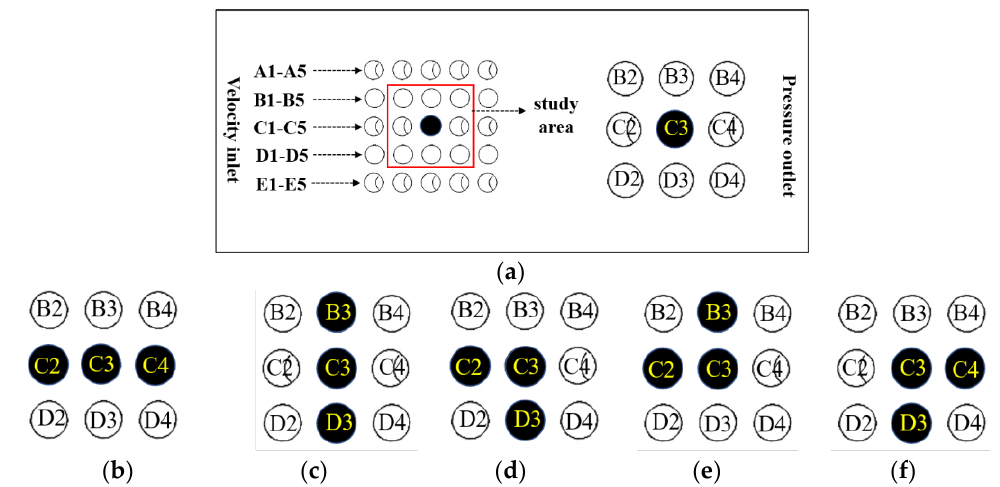
Figure 13. Distribution of vibrating tubes: ( a ) C3; ( b ) C2-C3-C4; ( c ) B3-C3-D3; ( d ) C2-C3-D3; ( e ) C2-C3-B3; ( f ) D3-C3-C4.